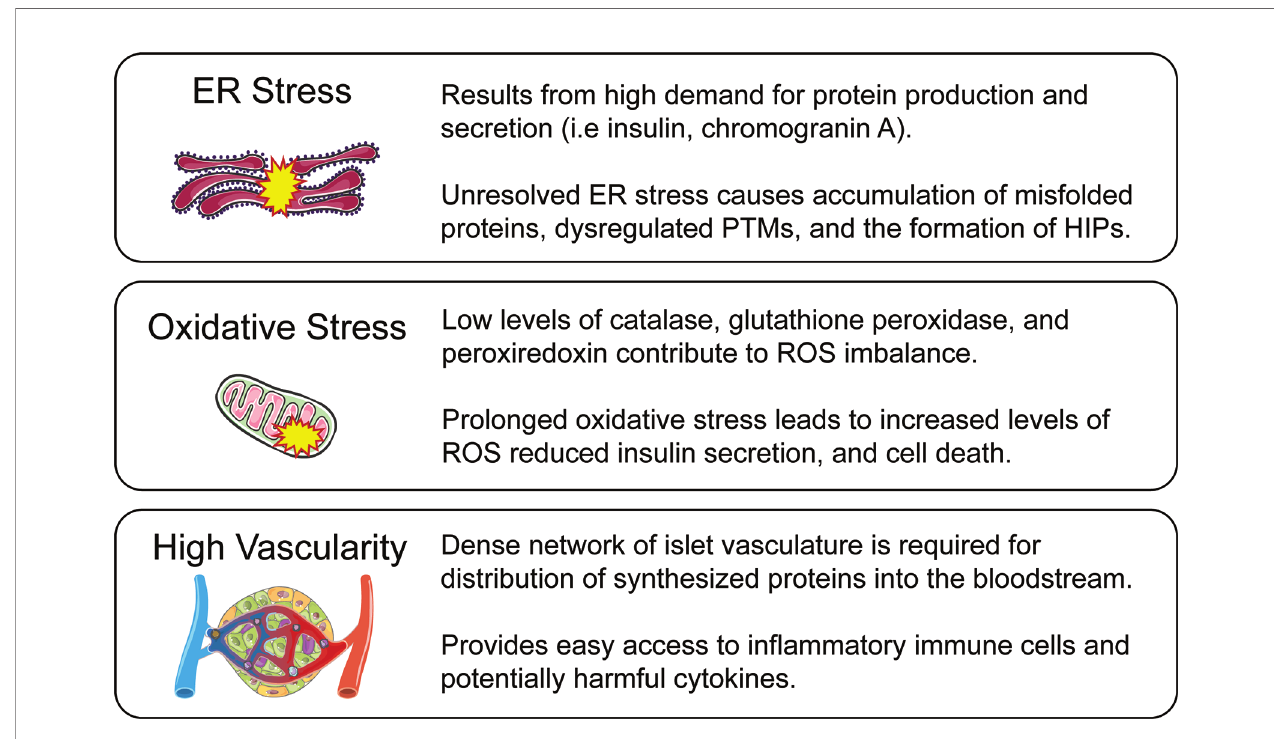
FIGURE 1 | Beta-cell vulnerabilities. While autoimmunity is a major driver of T1D pathogenesis, innate features of beta-cell biology make it a complicit partner in disease progression. These beta-cell characteristics are a result of normal beta-cell function while also active contributors to disease ampli fi cation. ER stress is caused by the high protein production and secretory demand of the beta-cell, but in excess leads to misfolded protein response and the generation of HIPs through PTMs. Oxidative stress is caused by an imbalance between the generation of ROS and their detoxi fi cation by antioxidants. The reduced antioxidant capabilities of the beta-cell can lead to impaired function and cell death. A densely vascularized environment is required for secretion of insulin and other peptides directly into the bloodstream, but creates a direct dialogue between the beta-cell and potentially harmful immune cells and in fl ammatory cytokines which may further lead the cell toward stress and